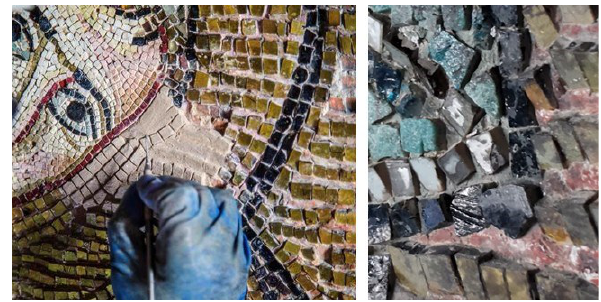
Figure 5. Mosaic tiles during the restoration work the diversity of the conformation between the wall and floor mosaics tiles was noted. The floor mosaics are characterized by different tile sizes, according to their function: black and white frame tiles with a size ranging from 1 cm to 1.5 cm per side and tiles for the decorative apparatus with a size of the side less than 1 cm. Despite localized yielding going on nowadays the different dimensions, the floor tiles share parallel positioning with respect to the ground, in order to constitute a walkable decorative carpet. Wall mosaic tiles, on the other hand, have a highly diversified course, linked to the point of view of the observer in the Basilica. They are in fact inclined along the horizontal line up to 30° facing the floor of the Nativity, arranged differently on the lodging plan.